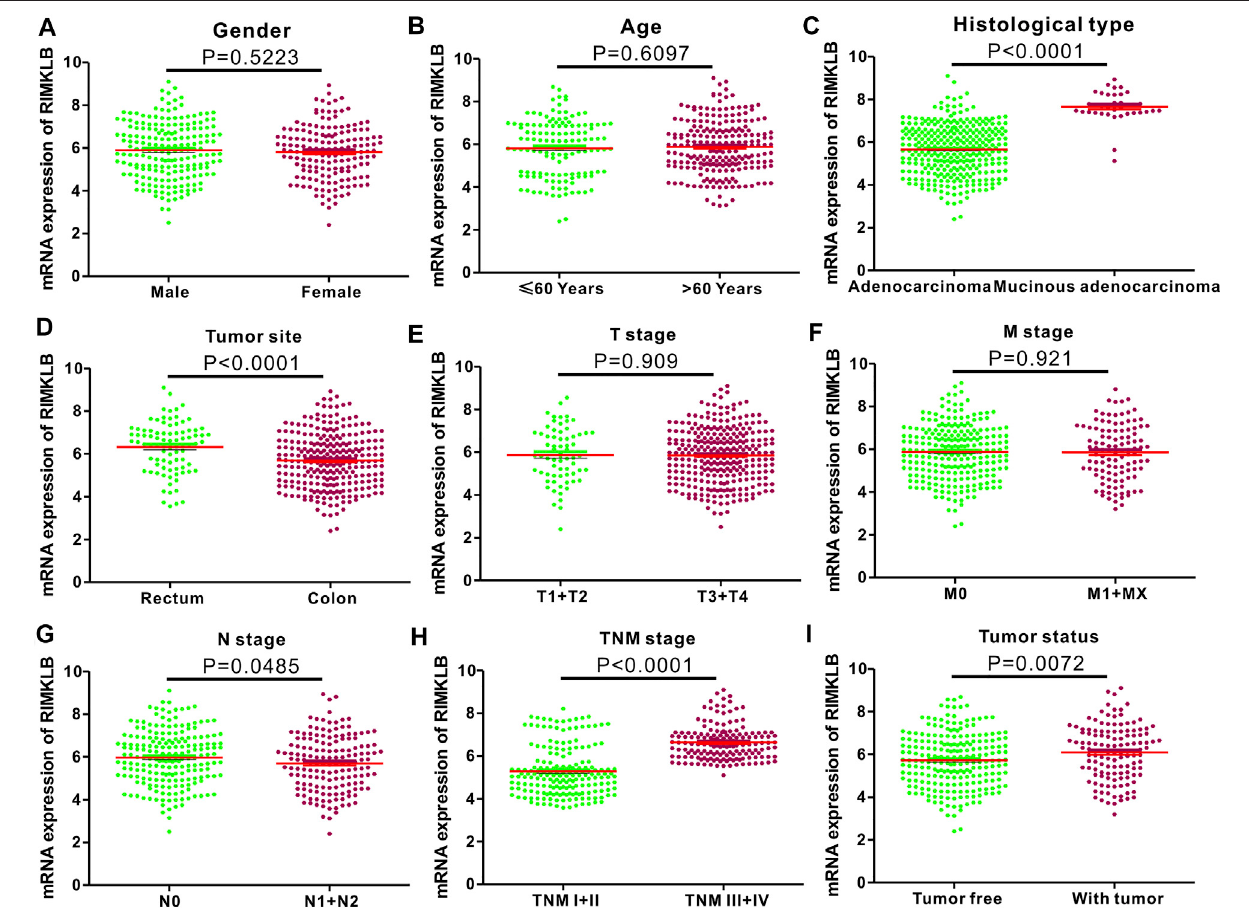
FIGURE 2 | Correlation between RIMKLB mRNA expression and clinical indexes of CRC patients from TCGA database. RIMKLB mRNA expression is strati fi ed with scatter plots using the TCGA dataset by gender (A) , gender (B) , histological type (C) , Tumor site (D) , T stage (E) , M stage (F) , N stage (G) , TNM stage (H) , and Tumor status (I)